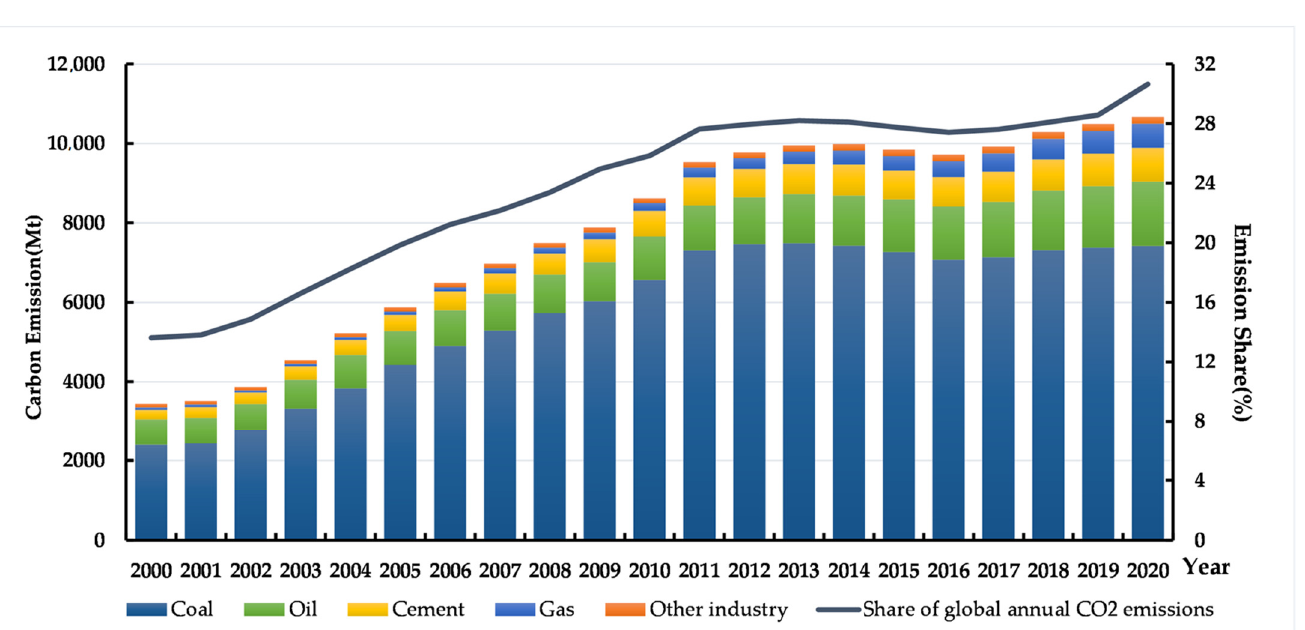
Figure 1. China’s CO 2 emissions by flue type and share of global CO 2 emissions. Source: Global Carbon Project.